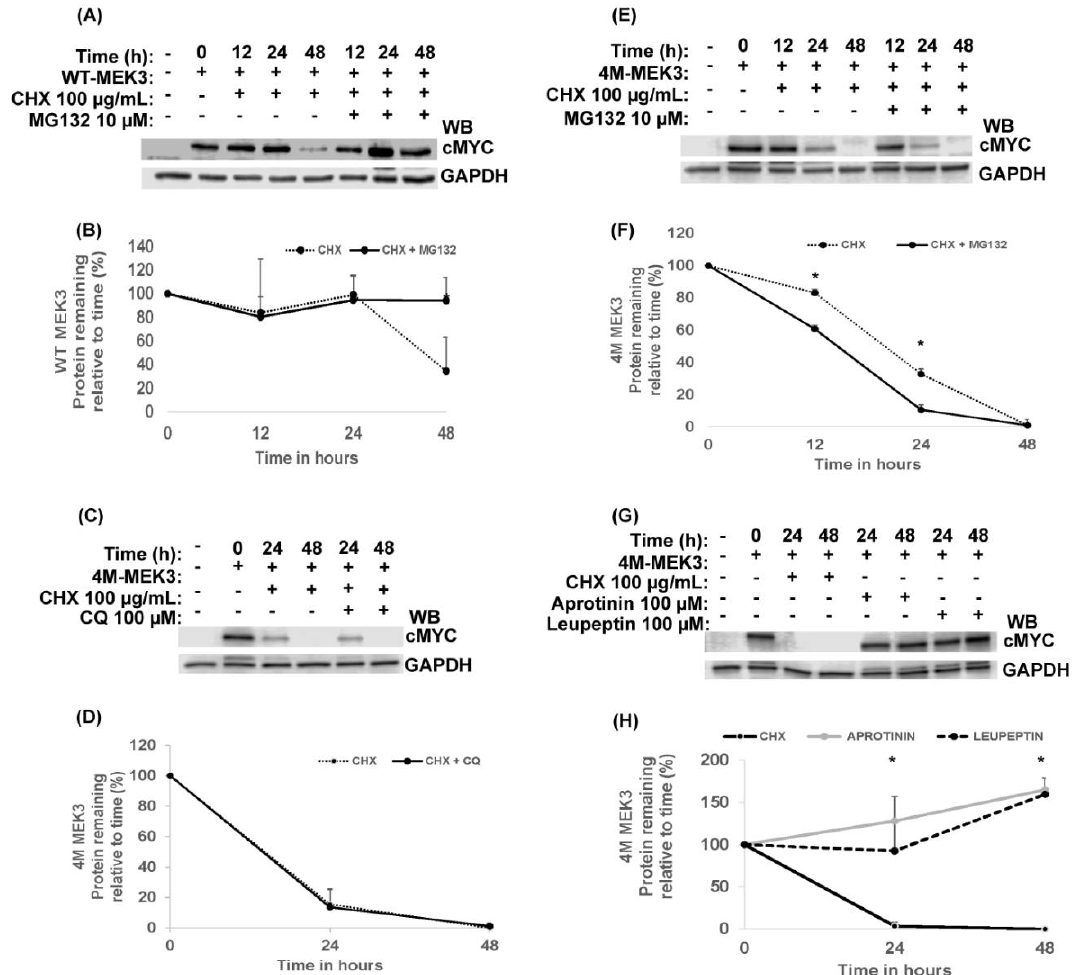
Figure 5. Cysteine/serine protease inhibitors rescue quadruple MEK3 mutant protein expression. HEK293 cells were not transfected ( − ) or transiently transfected with WT-cMYC or 4M-MEK3-cMYC mutant constructs. At 24 hours post-transfection, cells were left untreated ( − ) or treated with CHX or a combination with proteolytic inhibitors for the indicated time points. ( A , B ) WT-MEK3 was treated with MG132. 4M-MEK3 was treated with either ( C , D ) CQ, ( E , F ) MG132, or ( G , H ) cysteine/serine protease inhibitors. Cell lysates were separated by SDS-PAGE and immunoblotted (WB) as indicated. Quantified protein expression of WT-MEK3 or 4M-MEK3 is shown relative to time 0 (Lower panels B , D , F and H ). Band intensities were normalized to GAPDH using densitometric analysis and presented as a ratio of cMYC to GAPDH. Data are presented as mean ± SEM ( n = 3 and n = 2 for Panel H). A t-test (unpaired) was used to determine statistical significance. *, p < 0.05.